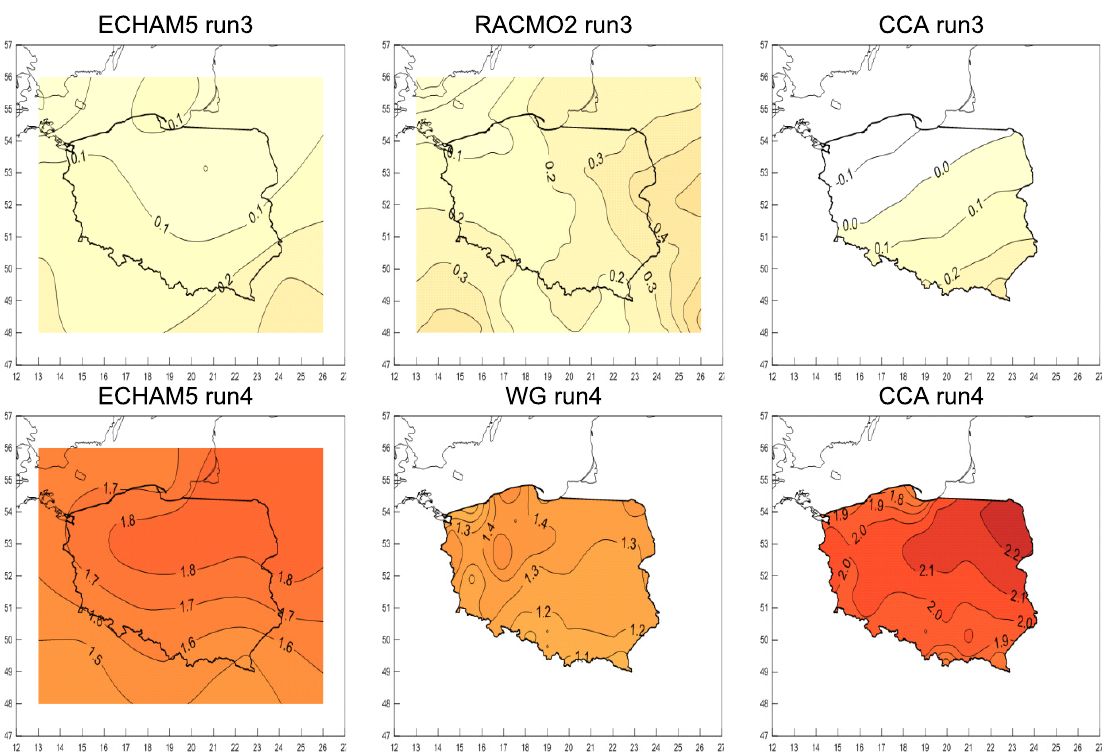
4.Fig. 5. Anomalies of air temperature (°C) in the winter season (DJF) 2011–2030 in relation to reference period (1971–2000) in Poland based on A1B emission scenario for models: ECHAM5 run 3and 4, RACMO2 run 3, CCA run 3 and 4, WG run